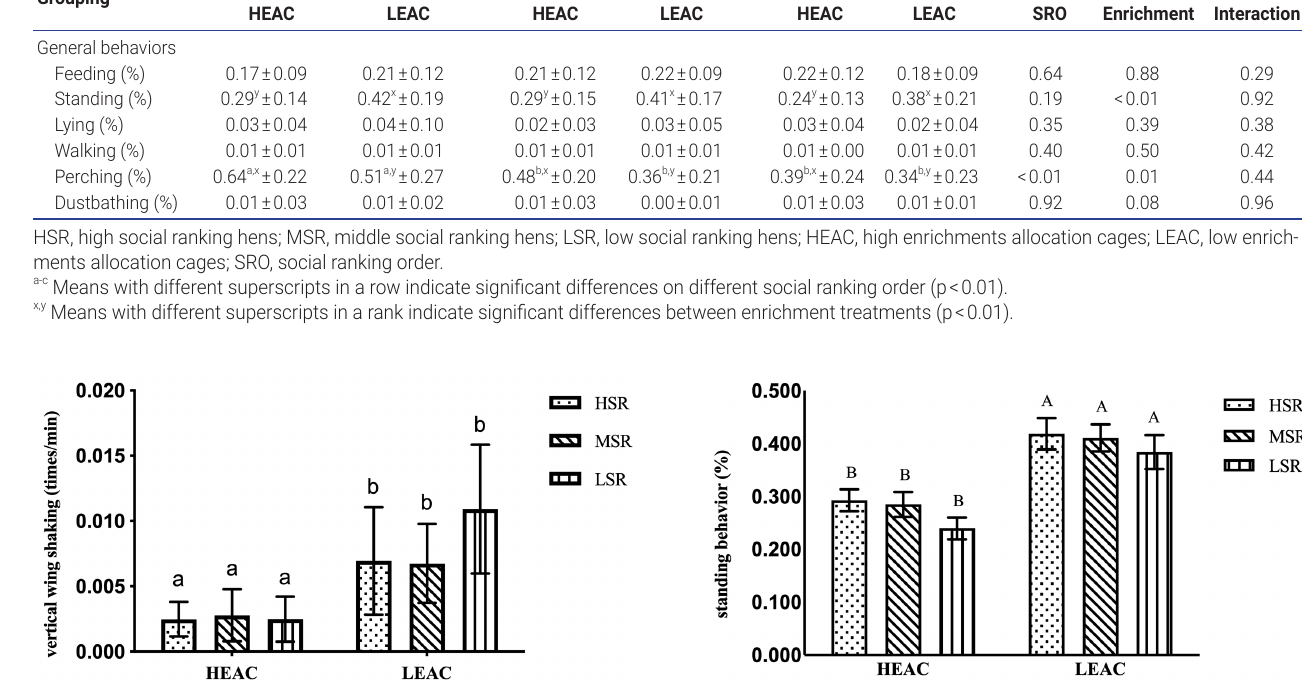
Figure 2. Effects of hen’s social ranking order (SRO) on standing be- havior in high and low enrichments allocation cages (HEAC and LEAC). A,B